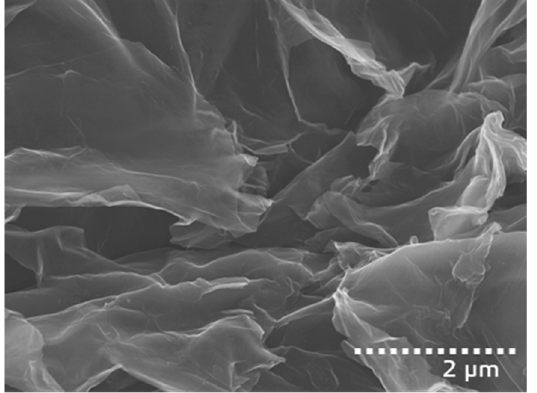
Figure 18. FTIR spectra of MB and rGO before and after three consecutive adsorption-desorption cycles.